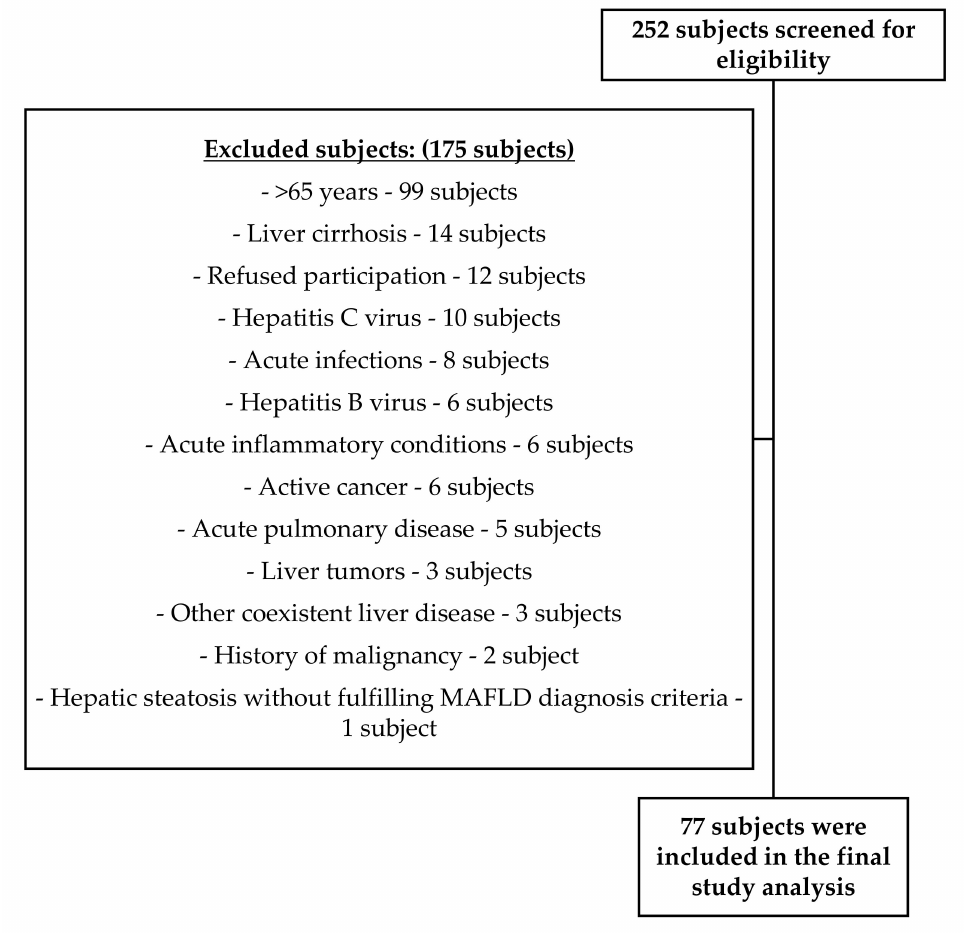
Figure 1. Flow diagram of included and excluded participants. Table 1. General characteristics of included